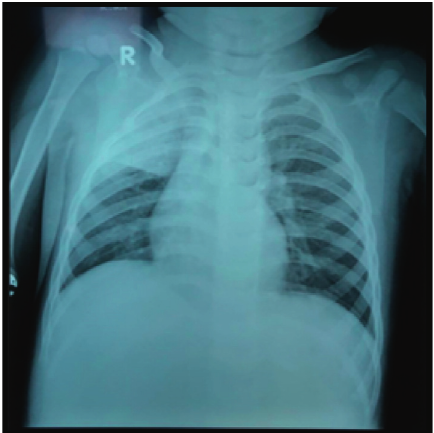
Figure 1: X-ray showing slight spotting in both lungs and ho- mogeneous consolidation in the right upper lung with firm borders consistent with superior right lobar pneumonia and broncho- pneumonia